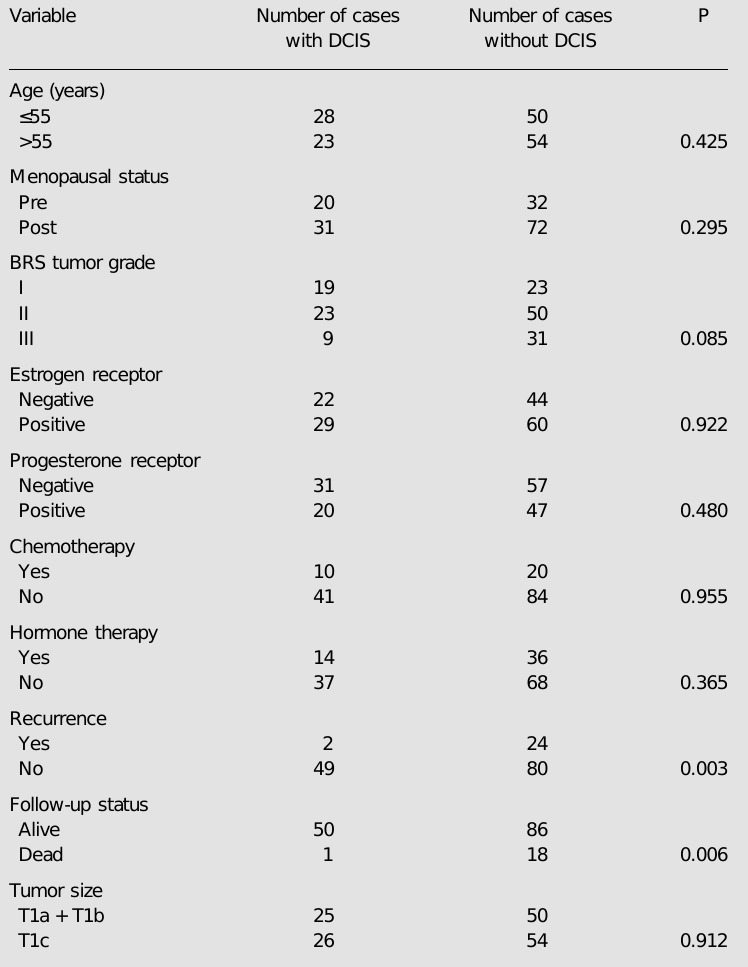
Table 2. Clinicopathological variables according to the presence or absence of ductal carcinoma in situ (DCIS) in infiltrating T1N0M0 ductal carcinomas. Variable